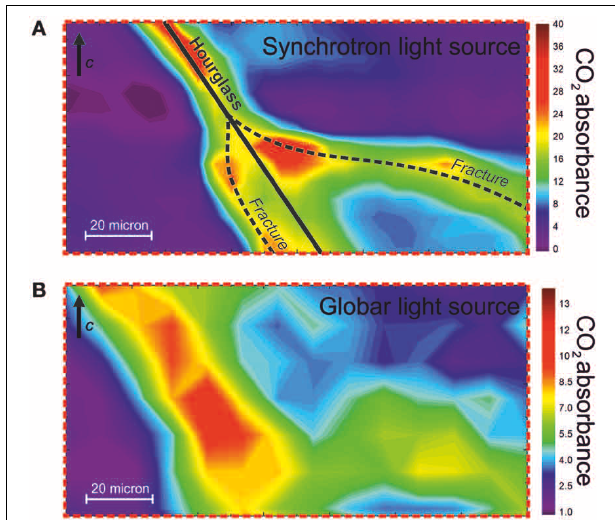
FIGURE 6 | (A) FTIR map of the CO 2 distribution in the indicated portion (red broken-line box in Figure 5D ) of the beryl sample; spectra collected with synchrotron radiation. The traces of the hourglass growth structure and the fractures are indicated. The same image obtained using a Globar IR radiation is given for comparison in (B) . The chromatic scale is proportional to the CO 2